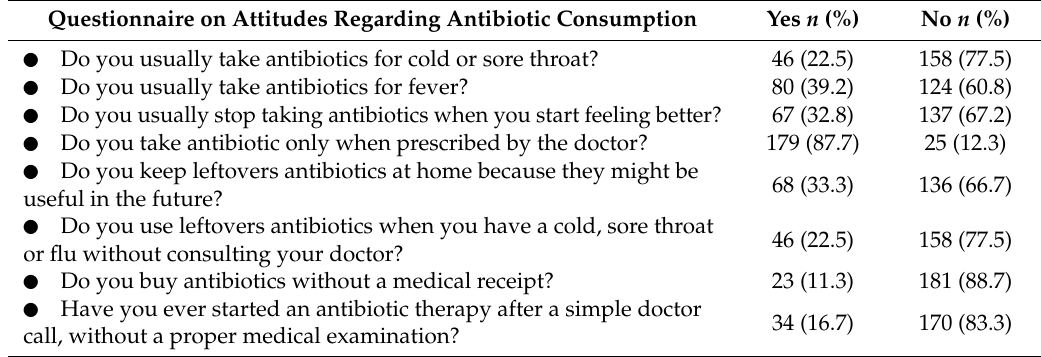
Table 4. Attitudes regarding personal consumption of antibiotics ( n = 204).